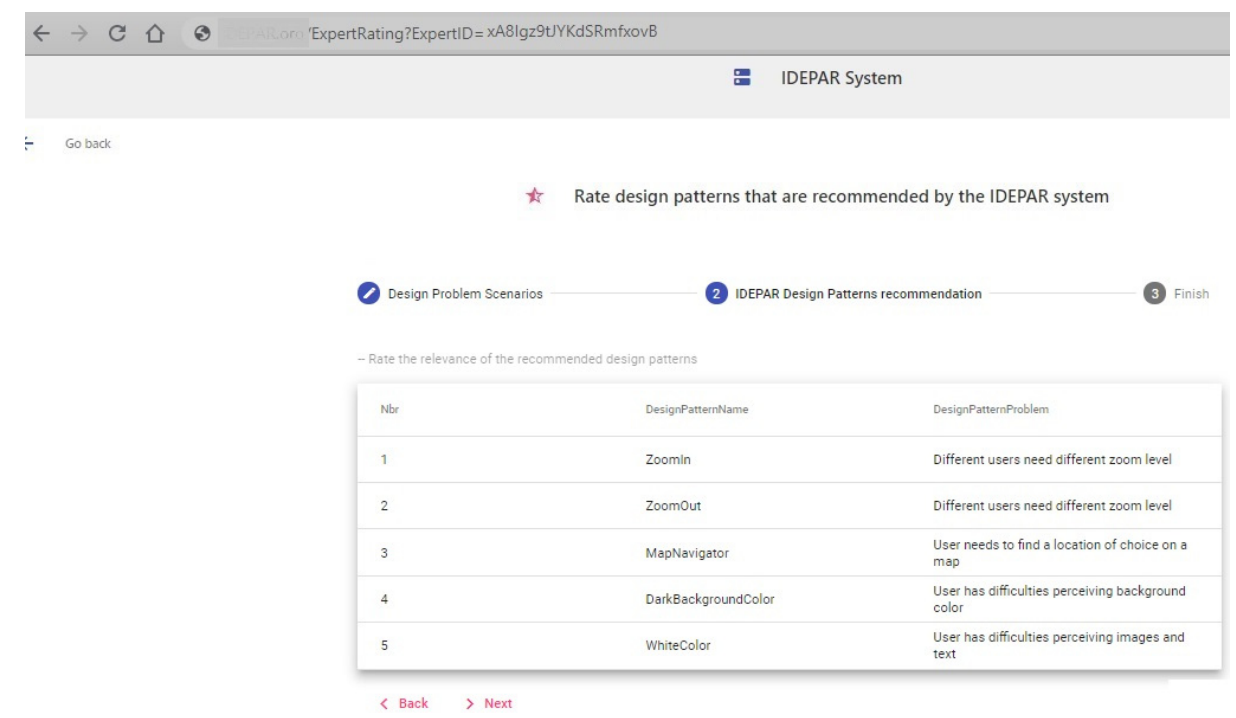
Figure 15. List of recommended design patterns for DPS-1.